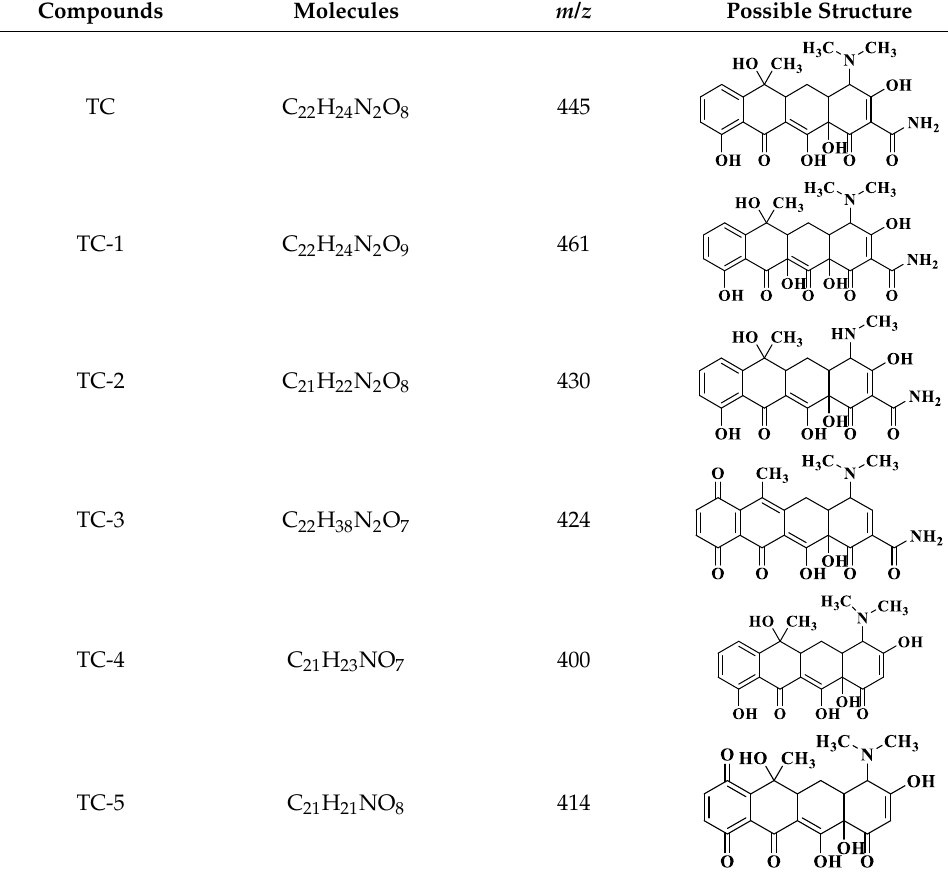
Table 3. The relative molecular weights and possible structural formulae of TC photo-degradation intermediates.